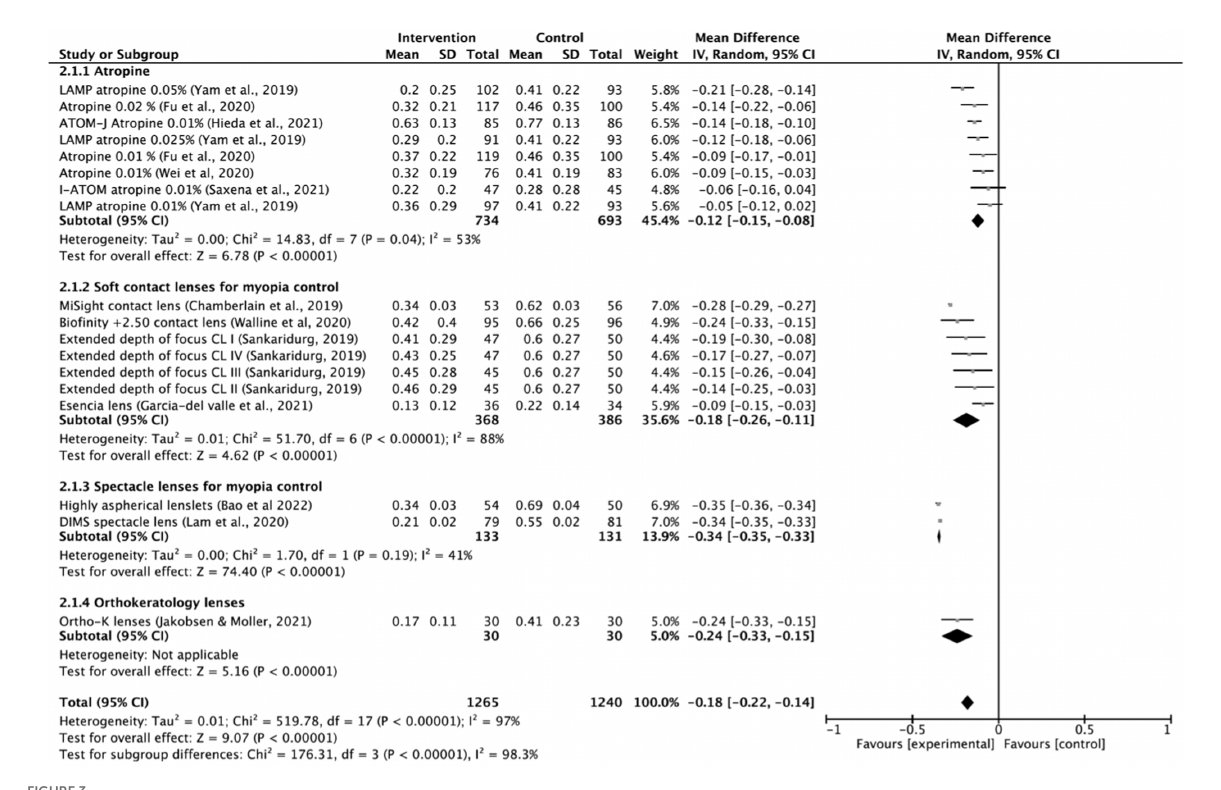
FIGURE 3 Forest plot of axial length elongation (mm) showing mean differences between treatment and control groups. The point estimate for the mean difference for each study is shown in gray color. The weight assigned to each study is represented by the size of each gray point estimate. The horizontal line through each gray point estimate shows the 95% confidence interval for the mean difference for each treatment. CL, contact lenses; CI, confidence interval; SD, standard deviation; K, keratology.